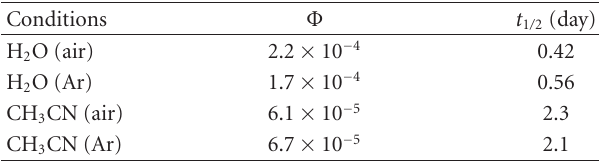
Table 1: Quantum yield of photolysis reaction of amlodipine.